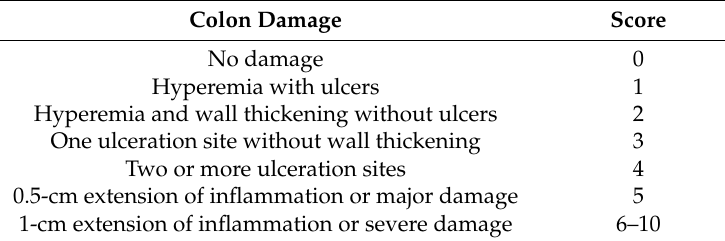
Table 1. Evaluation of macroscopic